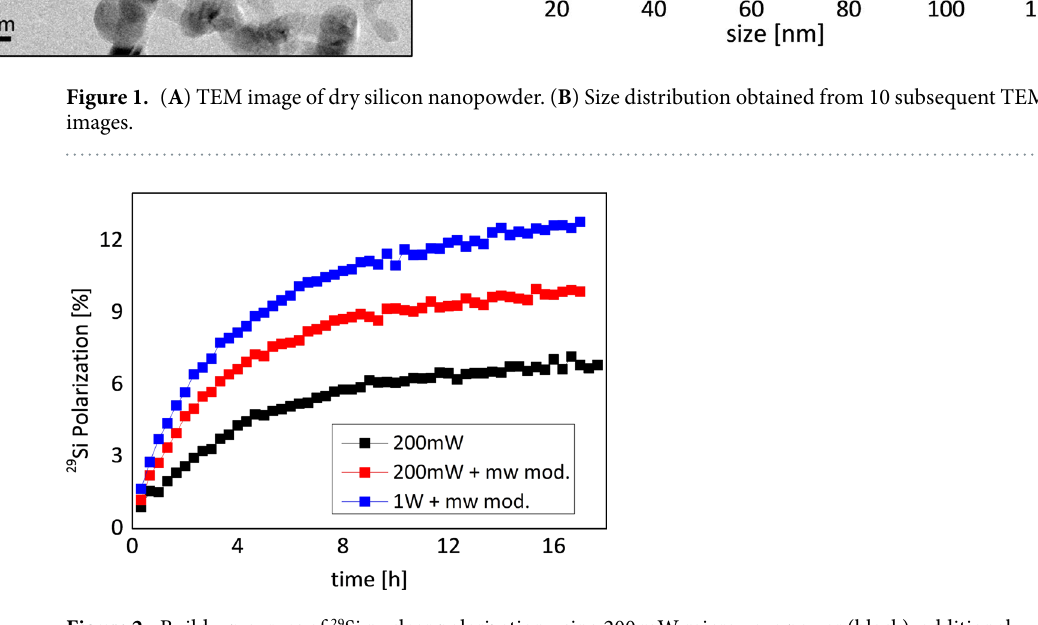
Figure 2. Build-up curves of 29 Si nuclear polarization using 200 mW microwave power (black), additional microwave modulation (red) and with a 1 W power amplifier and microwave modulation (blue). Maximum achievable polarization was